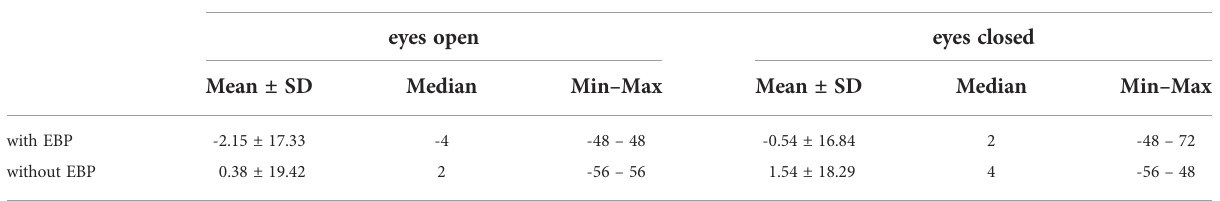
TABLE 3 Characteristics of the symmetry index in individual